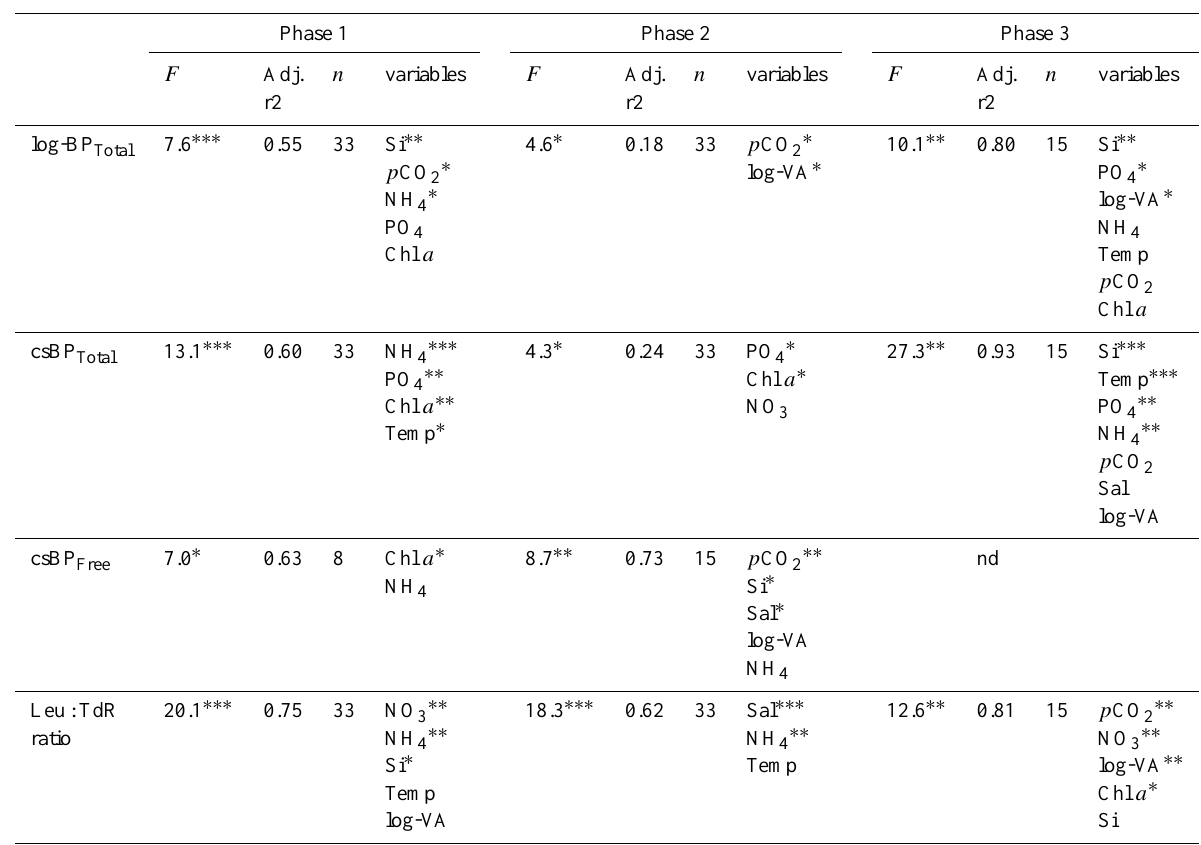
Table 1. Stepwise multiple regression analysis of log-BP Total , csBP Total , csBP Free , and Leu:TdR in phases 1, 2 and 3. ∗ : p < 0 . 05, ∗∗ : p < 0 . 01, ∗∗∗ : p < 0 .